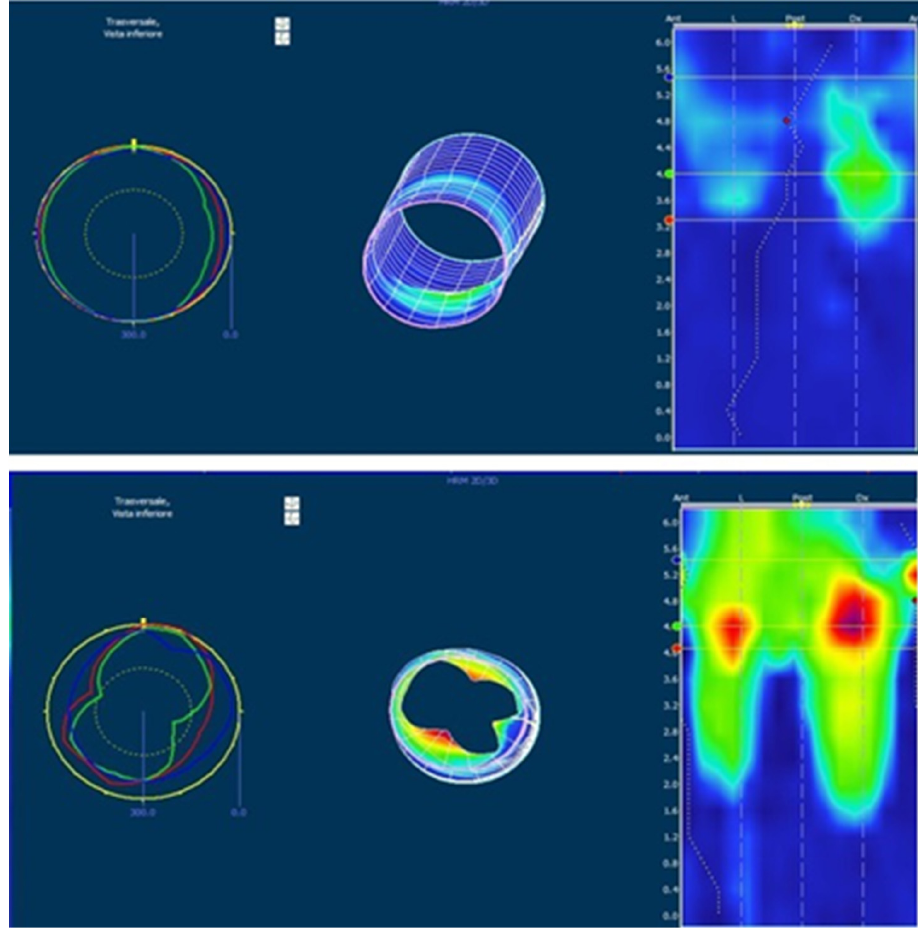
Figure 1. 3D high-resolution anorectal manometry (3d HRAM) in patients without ( A ) and with ( B ) sphincter anomalies. The image shows the 3D reconstruction of the anal canal at rest and after squeeze (images below). ( A ) Normal sphincter with good pressure values and symmetry; the pressure increment after squeeze is good for amplitude and symmetry. ( B ) Severe anal hypotonia and asymmetry with lower pressure in anterior, right and left segments at rest; during squeeze, the pressure is higher but not present in all segments.